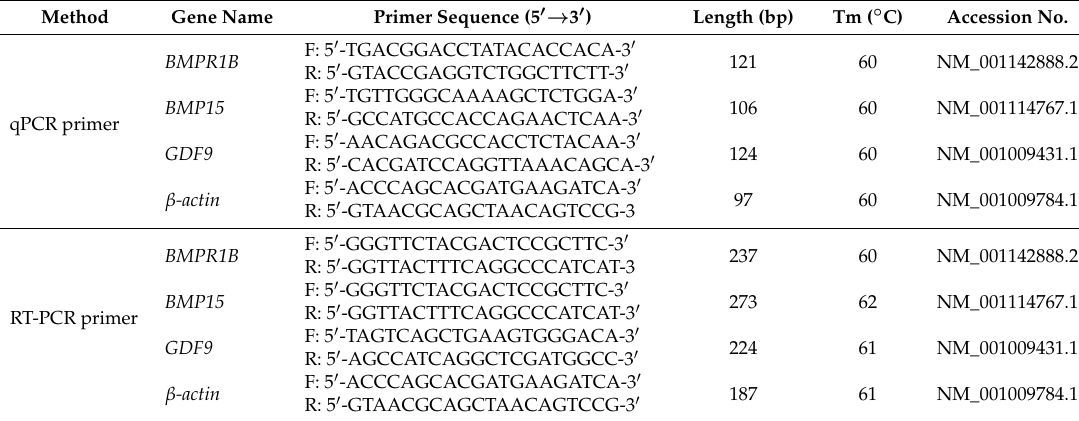
Table 1. Primers of studied genes.